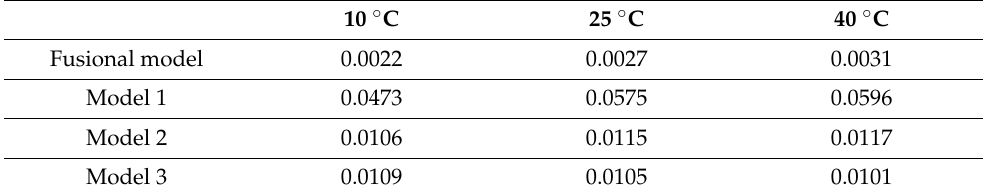
Table 5. RMSE of fusional OCV models and other models for NMC battery (V).